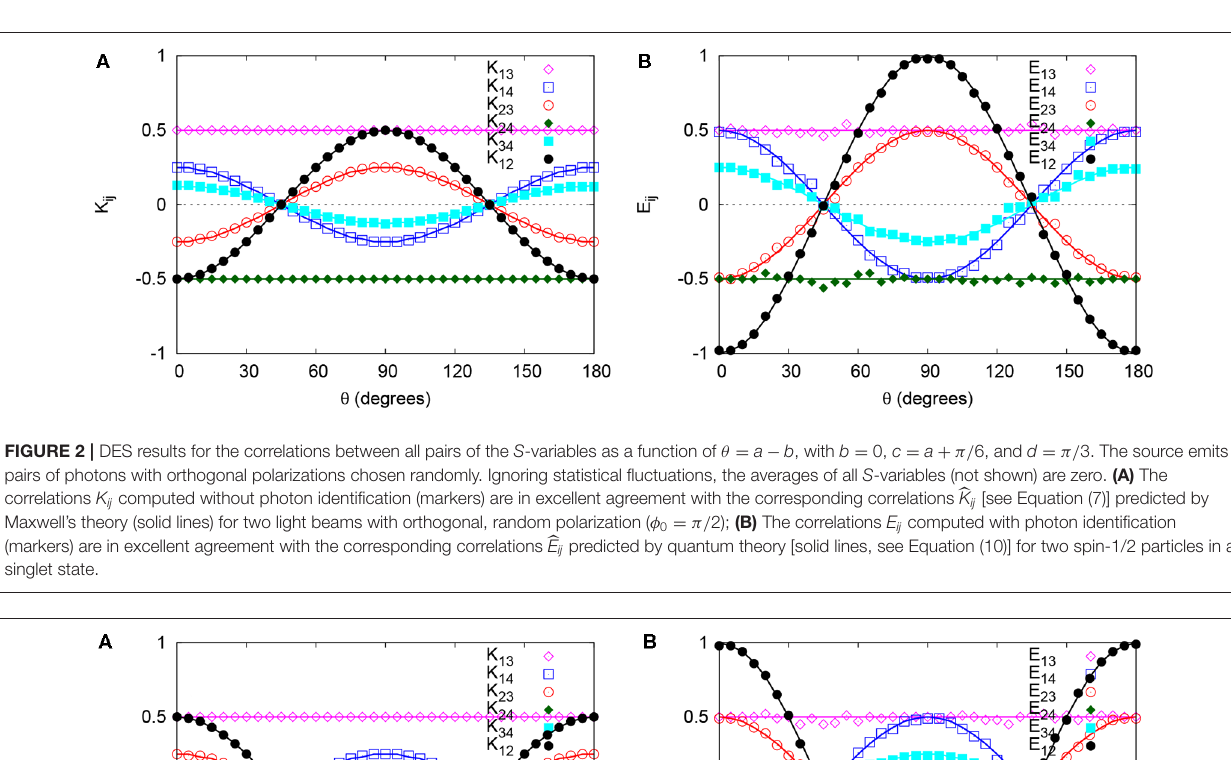
FIGURE 3 | Same as Figure 2 except that the source emits pairs of photons with the same instead of orthogonal polarizations chosen randomly. (A) The correlations K ij computed without photon identification (markers) are in excellent agreement with the corresponding correlations K ij (solid lines) predicted by Maxwell’s theory for two light beams with the same, random polarization ( φ 0 0); (B) The correlations E ij computed with photon identification (markers) cannot be obtained from quantum b = theory for two spin-1/2 particles (see Appendix B ) but are in excellent agreement with the corresponding correlations (solid lines) obtained from the expression Equation (9) in which the factor [